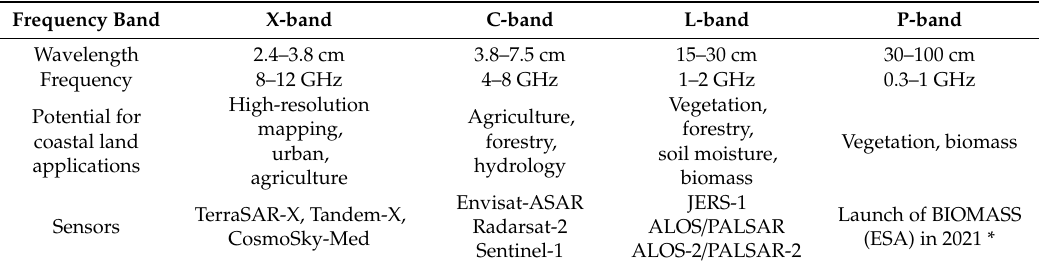
Table 1. Typical frequency bands of spaceborne SAR systems and their potential for coastal land